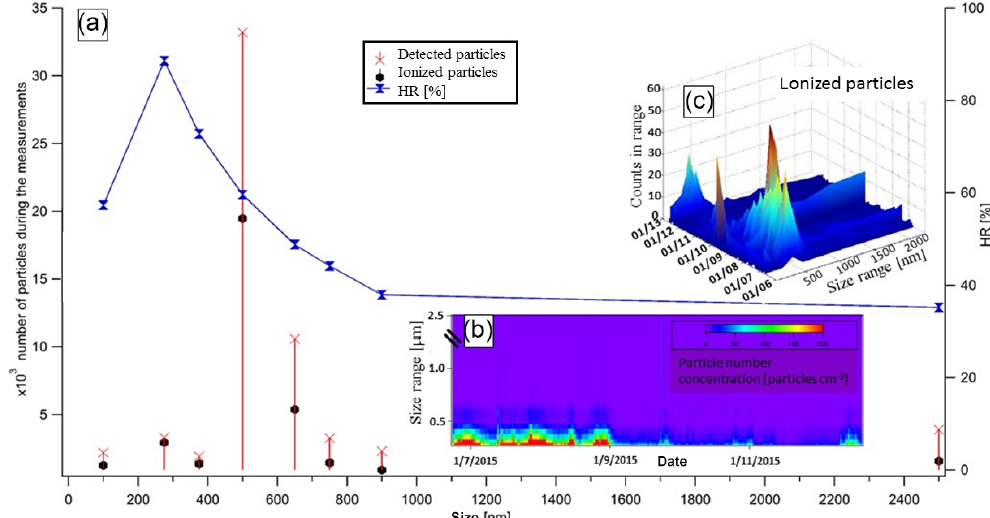
Figure 7. (a) Total number of particles detected and ionized during the ambient measurements in different size range and the hit rate corresponding to each size range (aerodynamic diameter). (b) The evolution of the particle number concentration of the ambient aerosol detected by the OPC during the measurements for different size range depicted between 275 and 2500nm (aerodynamic diameter). (c) The evolution of the number of particles ionized during the ambient measurements in different size range depicted between 10 and 2500nm.